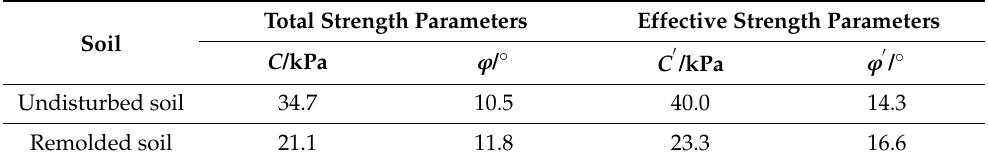
Table 2. Calculated cohesion and shear resistance angles.